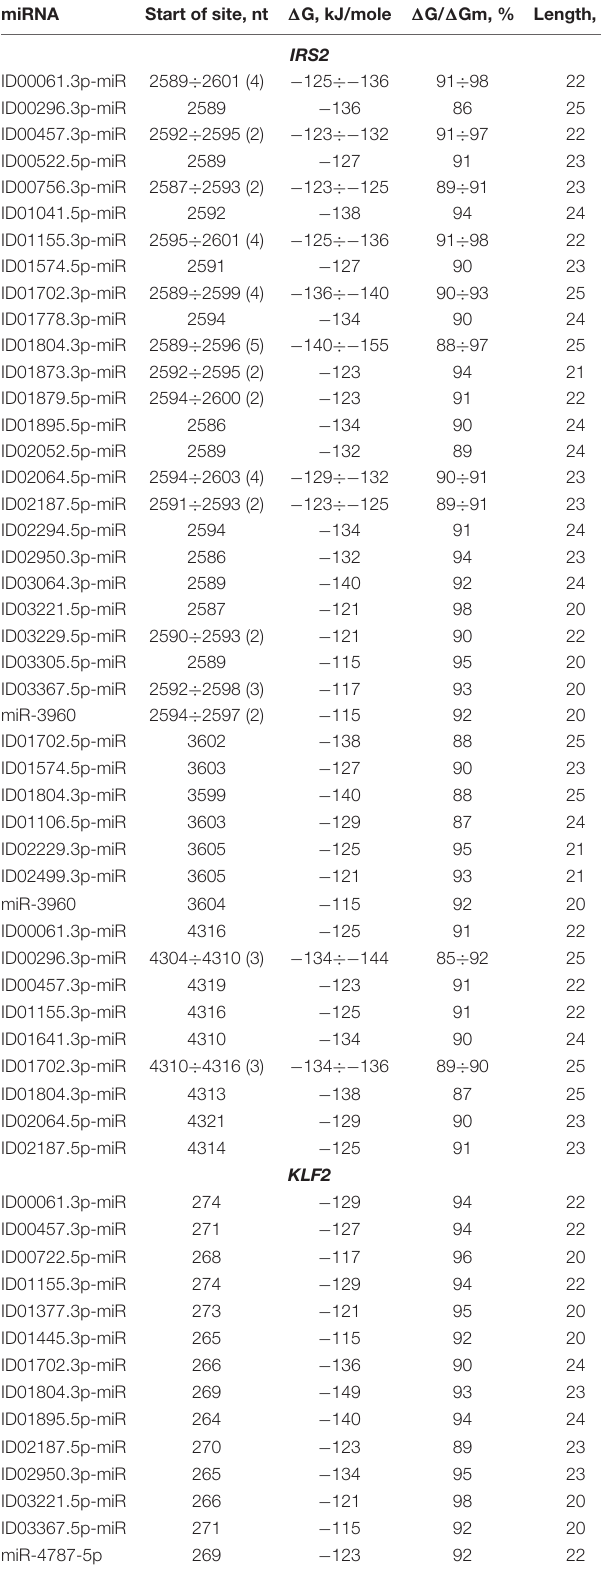
TABLE 2 | Characteristics of miRNAs interaction in the CDS of mRNA of IRS2 and KLF2 genes.